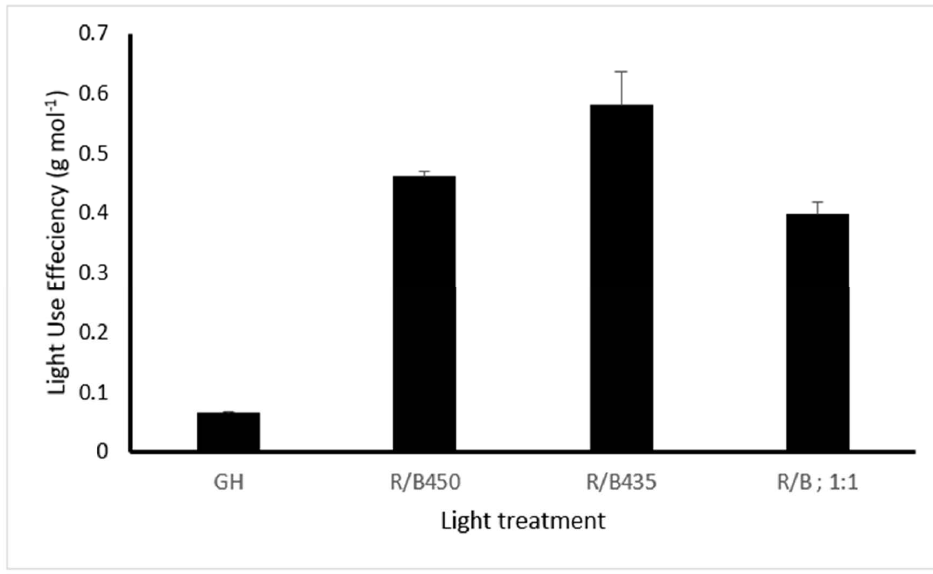
Figure 7. The effect of light treatments on the light used efficiency (LSD = 0.0745).